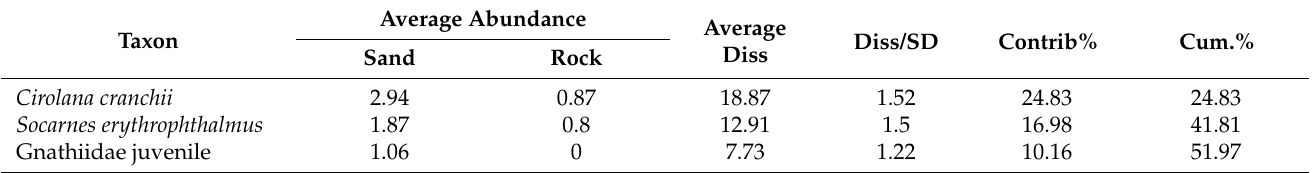
Table 8. SIMPER analysis results for the top contributors of the dissimilarity of scavenging ben- thopelagic macrofaunal assemblages between habitats as determined by PERMANOVA based on the four root density